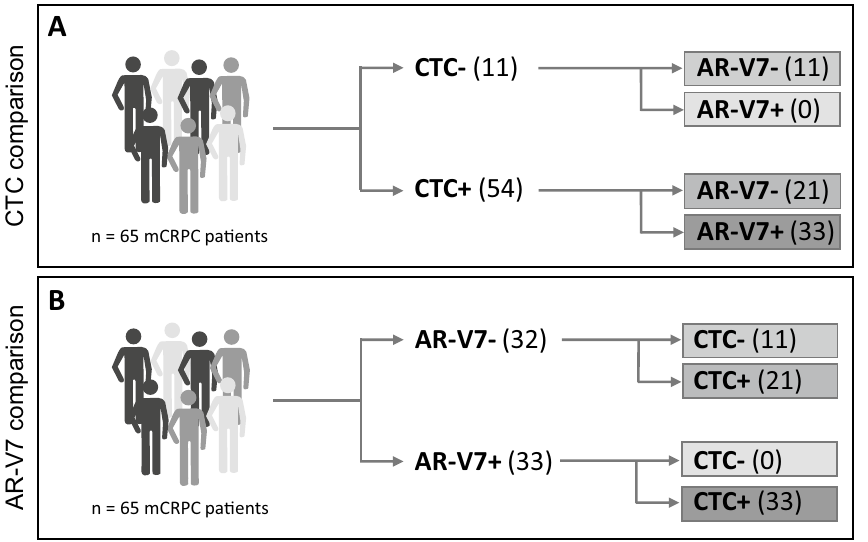
Figure 1. Patient subgrouping according to biomarker status. For comparative analysis of either CTC ( A ) or AR-V7 ( B ) as clinical biomarker, the overall cohort was stratified according to the respective biomarker status. Subsequently, subgroups were further subdivivded according to the respective other biomarker status. Colored boxes indicate identical